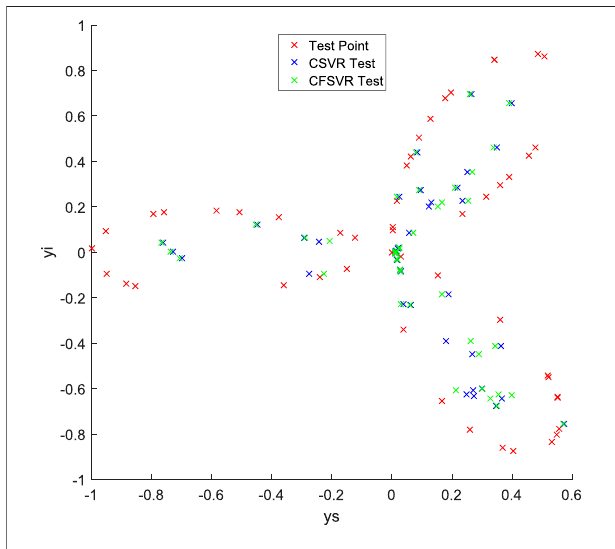
FIGURE 4 | Test result of non-linear regression.